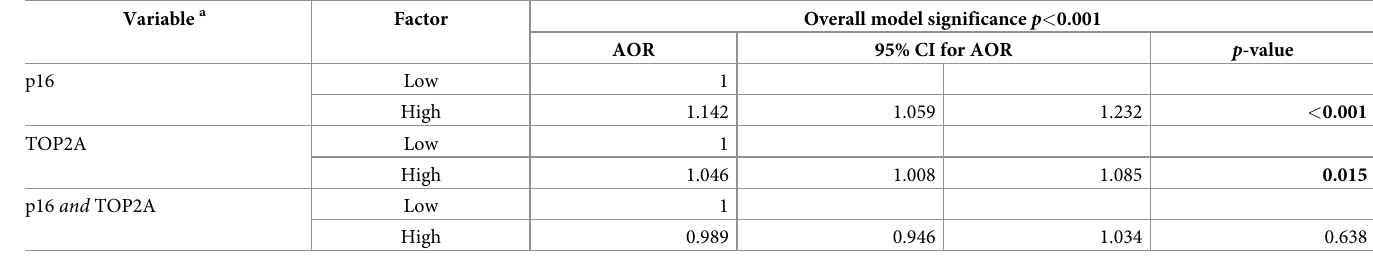
Table 5. Multivariate regression analysis and the strength of association between expression levels of p16 and TOP2A in differentiating cancerous cervical lesions from benign and precancerous cervical lesions among women seeking cervical cancer care at Kilimanjaro Christian Medical Centre (n = 139). Variable